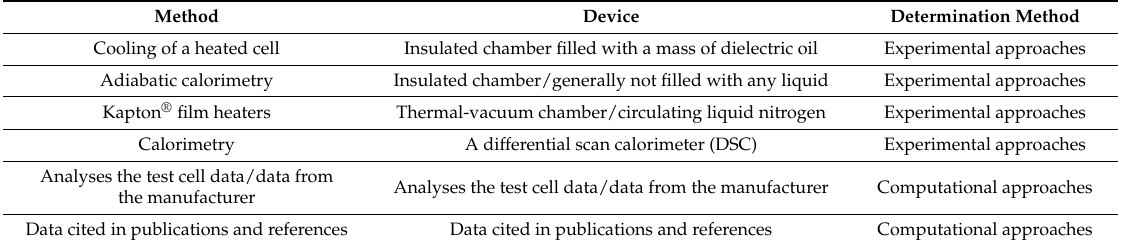
Table 5. Determination of the specific heat capacity of batteries using different approaches [35].